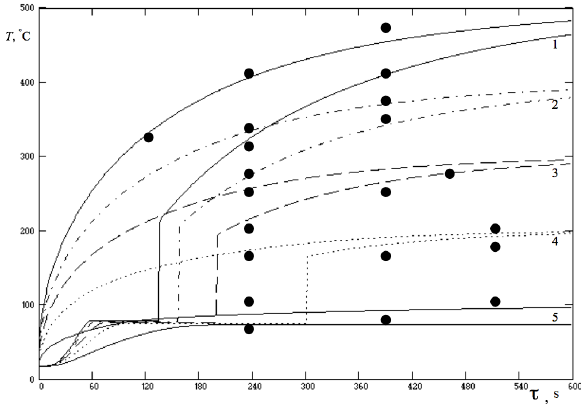
Figure 6. Time dependence of moisture content in the pellet at different temperatures of the drying agent T c : 1–100 ◦ C, 2–200 ◦ C, 3–300 ◦ C, 4–400 ◦ C, 5–500 ◦ C.